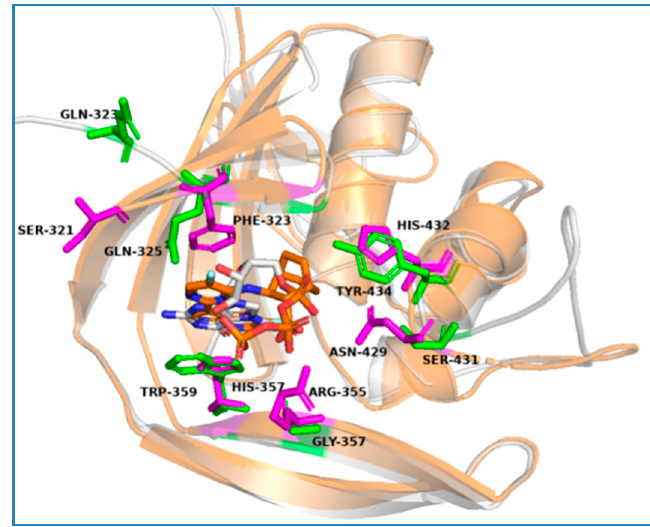
Figure 5. Three-dimensional structural overlay of the PB2 CBD of influenza A (H3N2) (PDB 4P1U, bound to VX-787) and influenza B/Lee/40 (PDB 5EFA, bound to M7GTP) and the key variant amino acid residues. PDB 4P1U is represented as an orange cartoon, and its key amino acid residues are shown with magenta sticks. PDB 5EFA is represented as a gray cartoon, and its key amino acid residues are shown with green sticks.